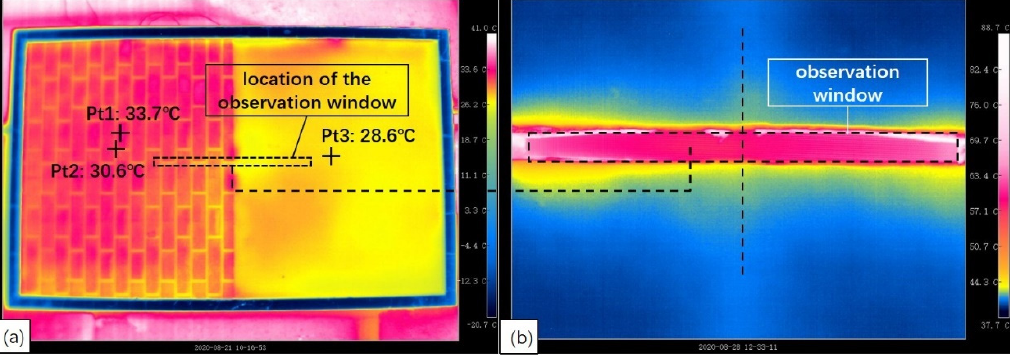
Figure 7. The infrared images. ( a ) The infrared image of the solar collector was taken from the front when irradiance was 791 W / m 2 and the ambient temperature was 26.9 ◦ C. ( b ) The infrared image of the solar collector was taken from the back when irradiance was 915 W / m 2 and the ambient temperature was 32.9 ◦ C. The dotted box in figure ( a ) corresponds to the position of the observation window in figure ( b ).